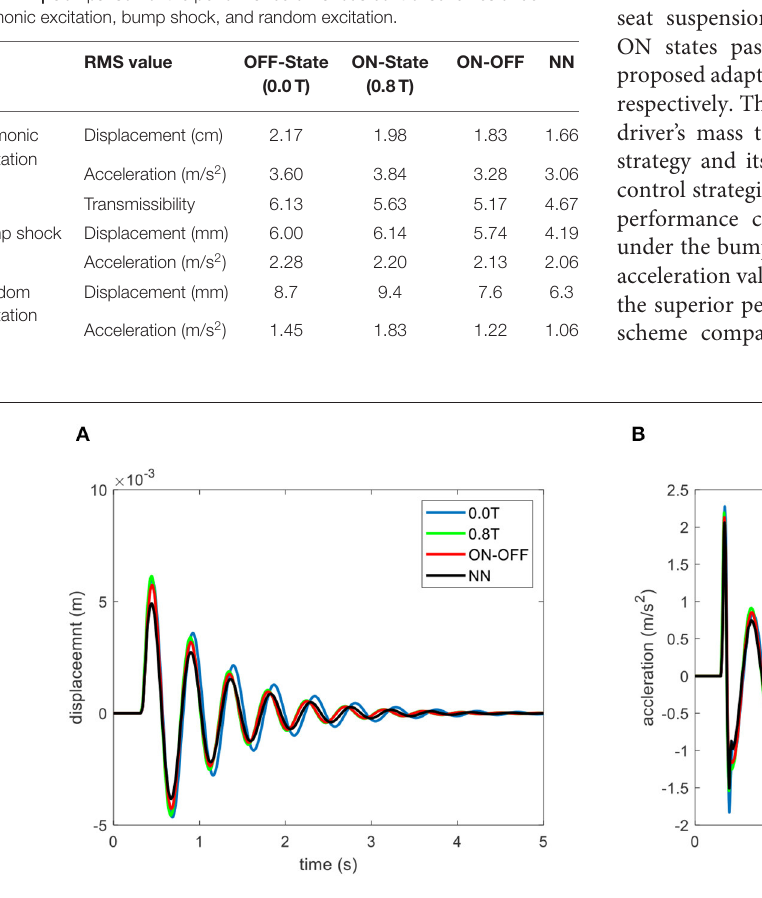
FIGURE 10 | (A) Displacement, and (B) acceleration of the human body ( x d ) for bump shock input in the presence of various controllers.